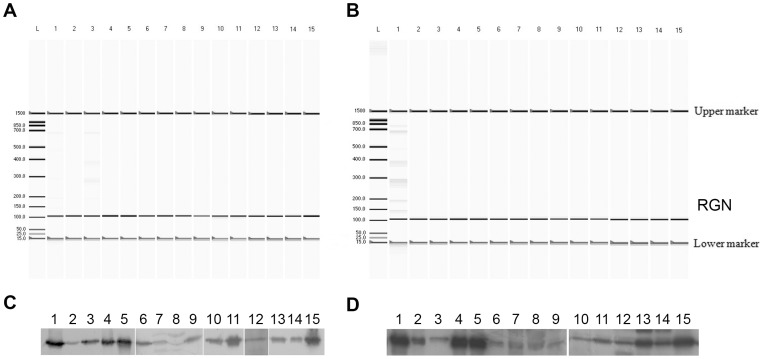
RGN expression in different bovine tissues and organs.A virtual gel of the automated capillary electrophoresis of the RGN amplicon (100 bp) in veal calves (A) and beef cattle (B). Two DNA internal markers (lower, 15 bp; higher, 1500 bp) were added to indicate peak alignments. A representative western blotting showing RGN protein expression in the different tissues and organs of veal calves (C) and beef cattle (D) using an anti-RGN rabbit polyclonal antibody (1∶200). Lane L: molecular weight marker; 1: liver; 2: kidney cortex; 3: perirenal fat; 4: adrenal cortex; 5: adrenal medulla; 6: lung; 7: heart; 8: skeletal muscle; 9: cervical thymus; 10: thoracic thymus; 11: pituitary gland; 12: salivary glands; 13: bulbo-urethral glands; 14: prostate; 15: testis.